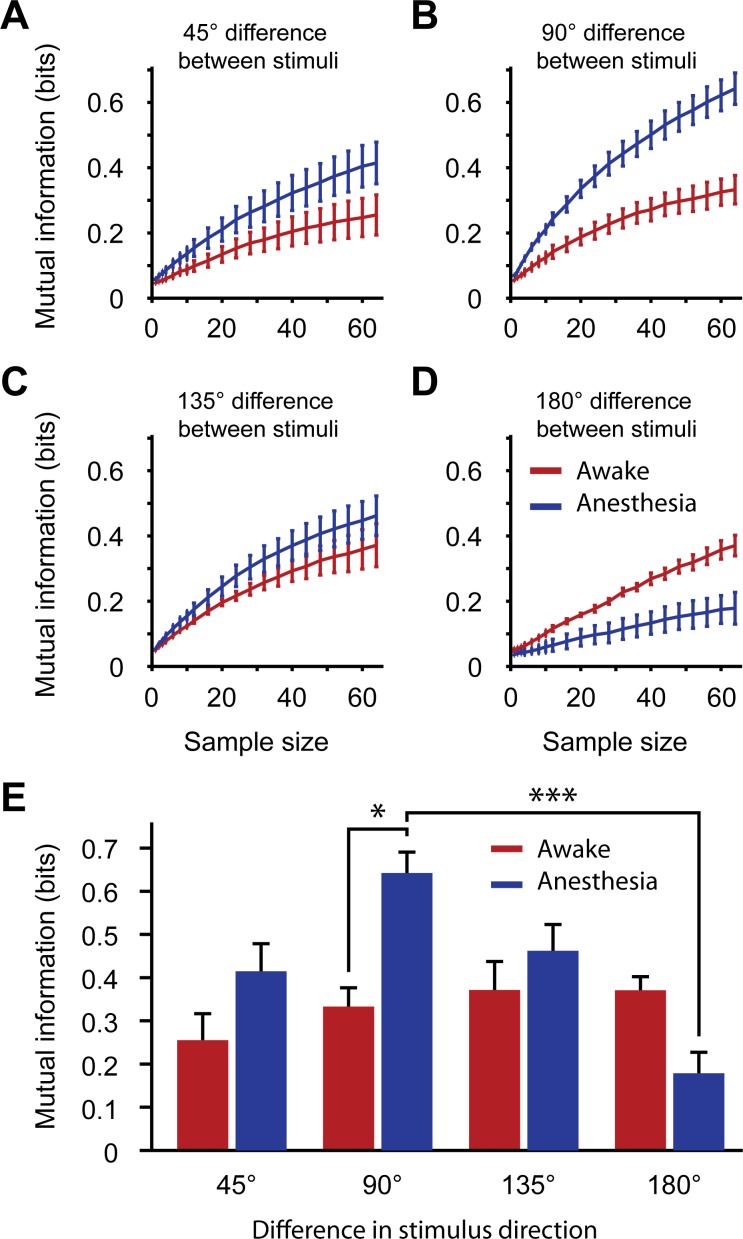
Population coding: Mutual information of stimulus orientation and direction as a function of ensemble size.(A) Mutual information of single trial ΔF/F responses to stimuli that differed 45° in movement direction. Mutual information was quantified as mean bits per trial across differently sized groups of neurons (ranging from 1 to 64 cells), averaged (± SEM) across unique stimulus combinations for the awake (red line) and anesthetized (blue line) condition. (B) Idem, for stimuli differing 90° in direction. (C) Idem, for stimuli differing 135°. (D) Idem, for stimuli differing 180° (opposite movement directions). (E) The mean mutual information on stimulus direction for a sample size of 64 neurons. Mutual information for each unique stimulus combination was determined by averaging across 2000 unique samples of 64 neurons from the entire population. The mean (± SEM) was taken across unique stimulus combinations (n = 8 for 45°, 90° and 135°; n = 4 for 180°). Data from awake (red) and anesthetized (blue) mice are displayed separately as a function of the angular difference in stimulus combinations (* p < 0.05, *** p < 0.001).